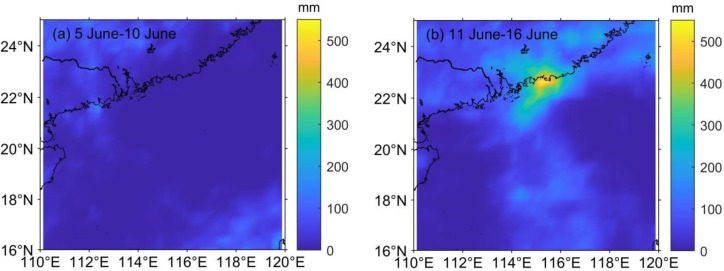
Accumulated 6-d rainfall (a) before (5 June-10 June) and (b) during and after (11 June-16 June) Merbok passage.